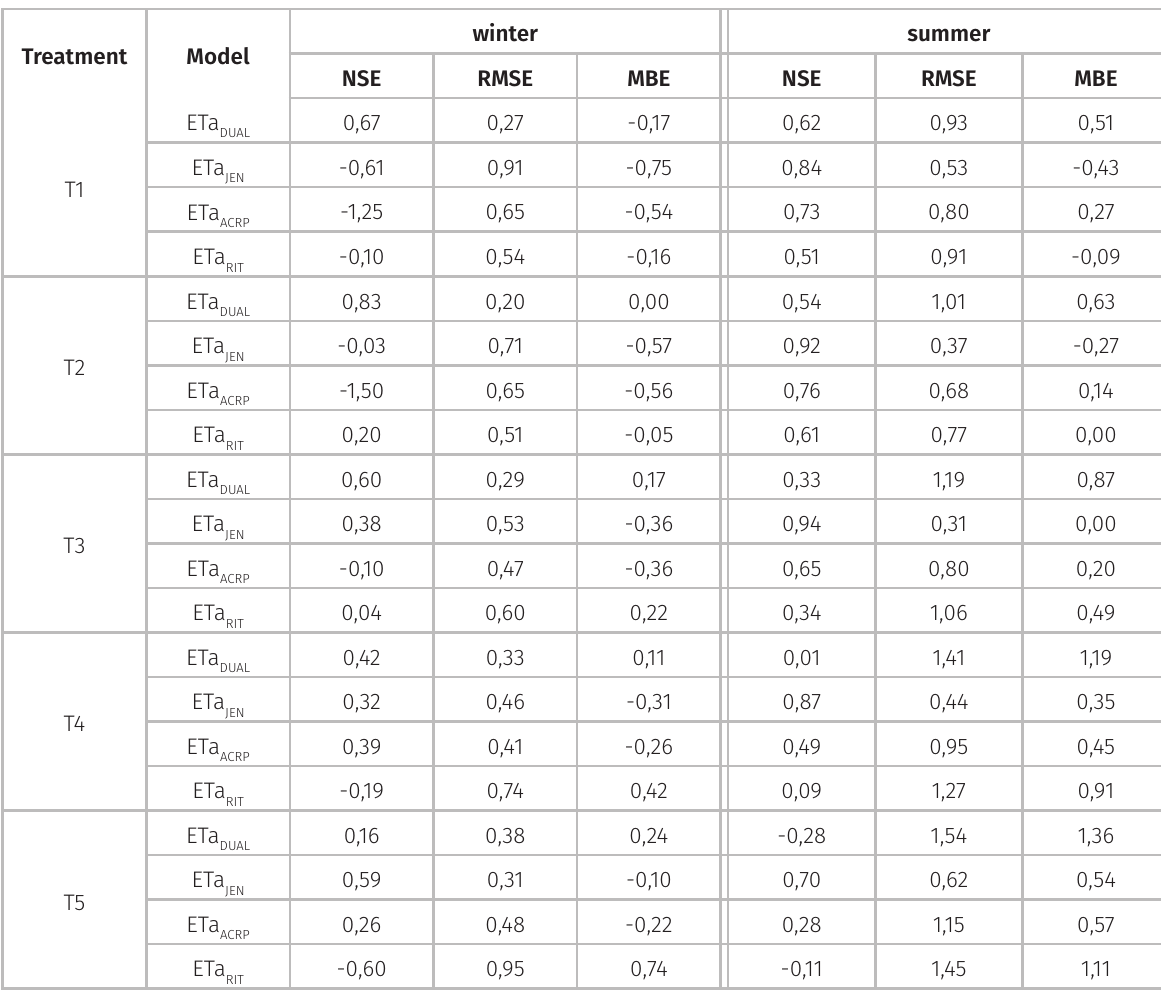
Table III. Performance indicators for the models FAO56 Dual (ETa (ETa ) and Ritchie (ETa ) in the estimation of the actual evapotranspiration of soybean crop, considering the ACRP RIT treatments [T1: water available in the soil (AW) of the 80-100%; T2: 60-80% AW; T3: 40-60% AW; T4: 20-40% AW and T5: 0-20%